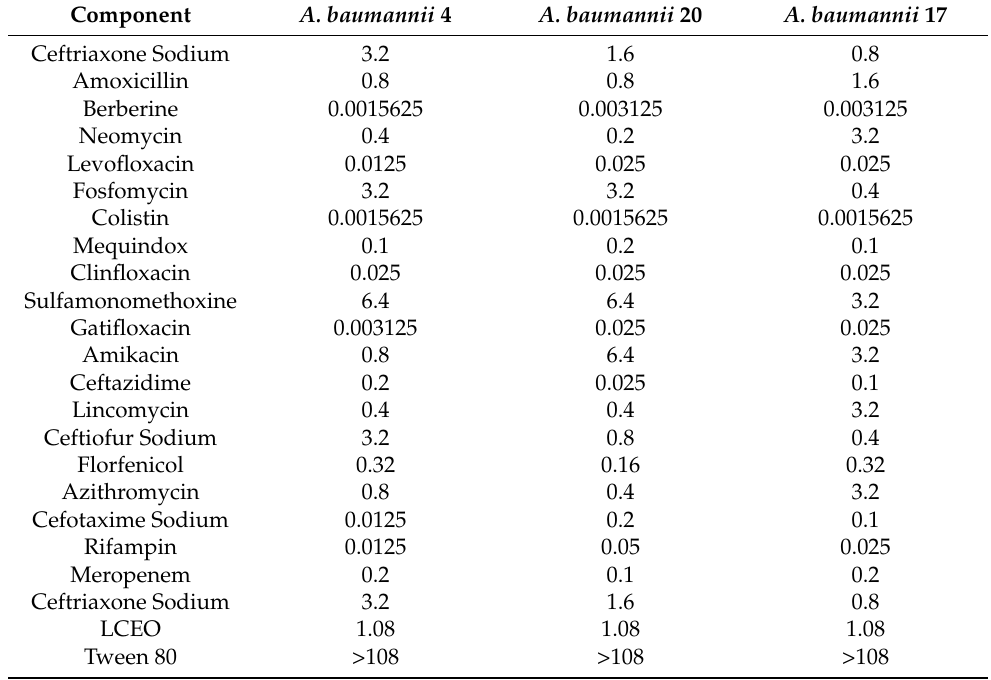
Table 3. Minimum inhibitory concentration (MIC) values (mg/mL) of tested components